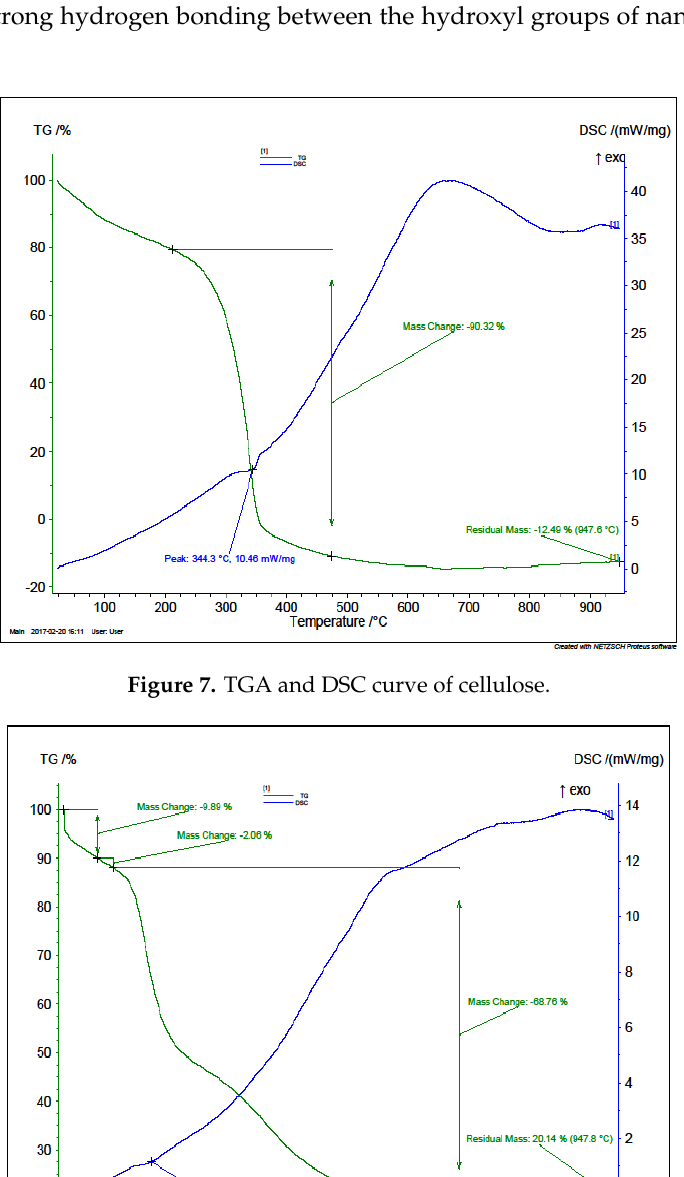
Figure 8. TGA and DSC of nanocellulose.